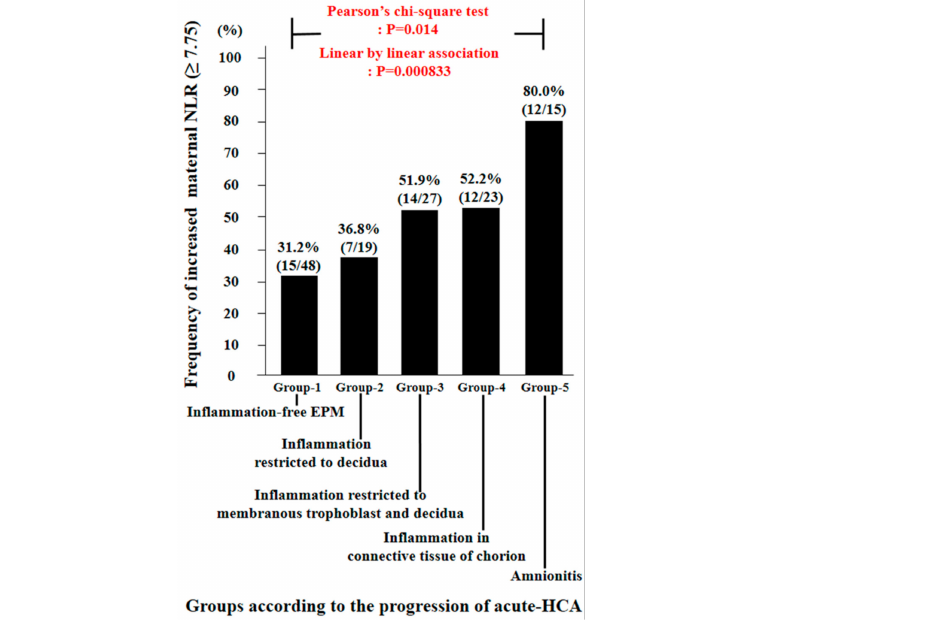
Figure 2. Frequency of increased maternal neutrophil to lymphocyte ratio (NLR) ( ≥ 7.75) according to the progression of acute histologic chorioamnionitis (acute-HCA) in extra-placental membranes (EPM). Each p value is shown in the graph. Table 3. Relationship of various independent variables with amnionitis analyzed by overall logistic regression analysis. Odds Ratio 95% Confidence